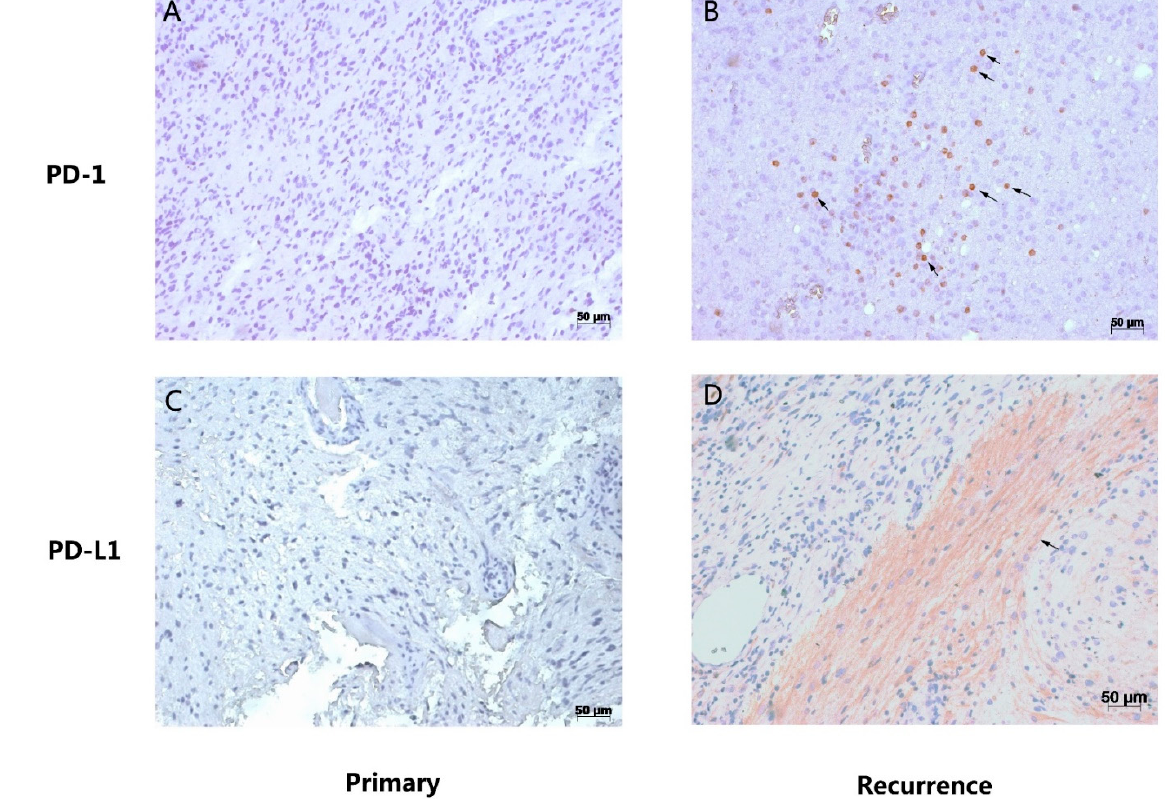
Figure 4. Expression of PD-1 and PD-L1 in two representative patients with primary and paired recurrent gliomas. One patient was diagnosed as having PD-1 -negative glioblastoma after the first operation in 2013, and the histological diagnosis was still glioblastoma ( A ), with recurrence in 2014, but where the expression of PD-1 was positive ( B ). Another patient was diagnosed as having PD-L1 - negative anaplastic astrocytoma after the first operation in 2012 ( C ), and the histological diagnosis was glioblastoma when there was recurrence in 2014, and the expression of PD-L1 was positive ( D ).